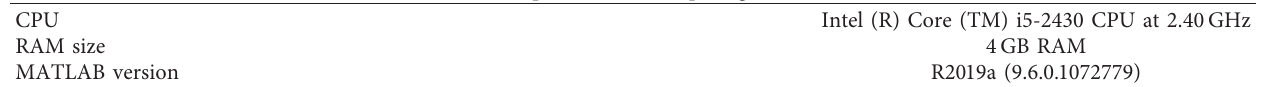
Table 1: Description of the computing environment.